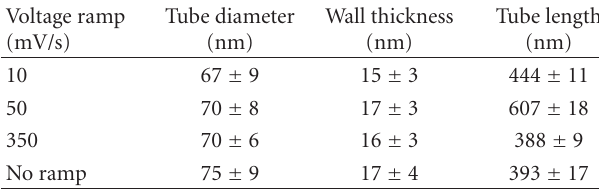
Table 1: Dimensional data of TNT produced at di ff erent voltage ramps prior to constant voltage of